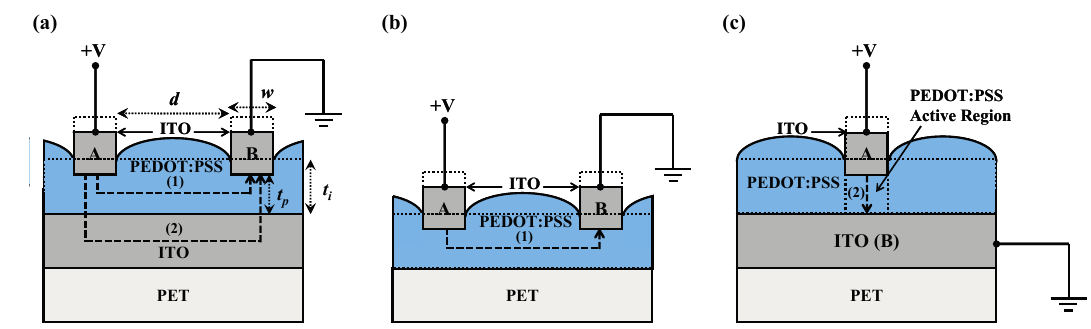
Figure 5. Schematic diagrams of the carrier conducting pathways of the pressure sensors with ( a ) inter-digitated electrode (IDE) with bottom indium-tin-oxide (b-ITO); ( b ) IDE without b-ITO; and ( c ) cross-point electrode (CPE) structures.